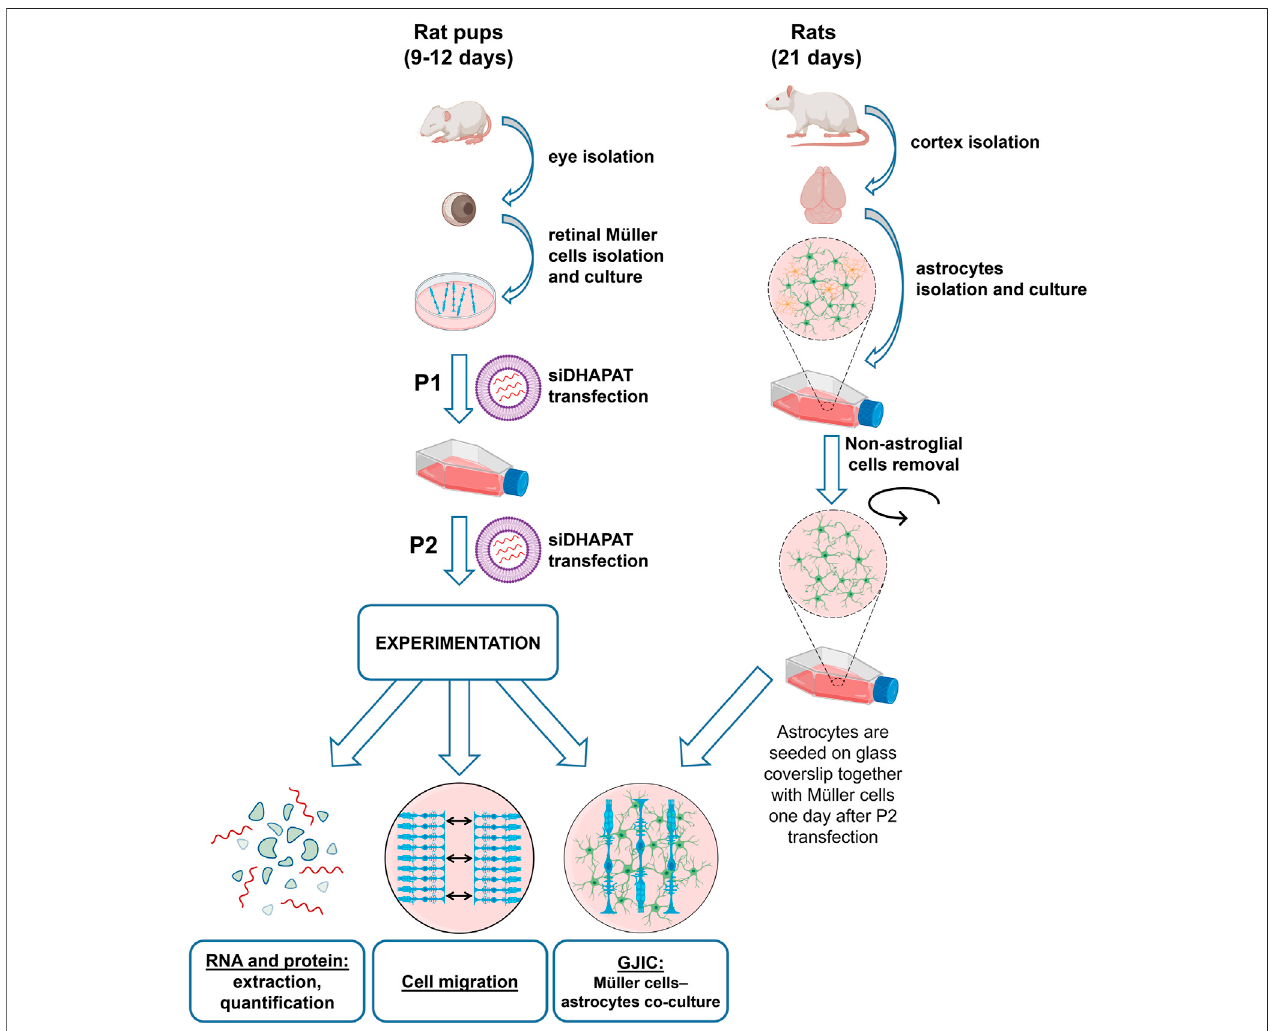
FIGURE 1 | Experimental procedure of plasmalogen depletion using a siRNA-based approach targeting DHAPAT in primary rat retinal Müller cells. Primary Müller cellswerepreparedfromratretinasaccordingtoapreviouslydescribedprocedure(HicksandCourtois,1990)withslightmodi fi cations.Brie fl y,eyeswereisolatedfrom9 to12 days-old rats. Isolated retinaswere thendissociated intosmall pieces and placed intoapetridish. Cellsat 80%con fl uence werereseeded (P1)ina75 cm 2 culture fl ask and transfected with a control or DHAPAT-targeting siRNA depending on their fi nal use. The procedure was repeated until the cells have received a second transfection and were then used at second generation (P2). See Materials and methods 2.1 for the complete primary Müller cells and astrocytes isolation, transfection and co-culture procedure.